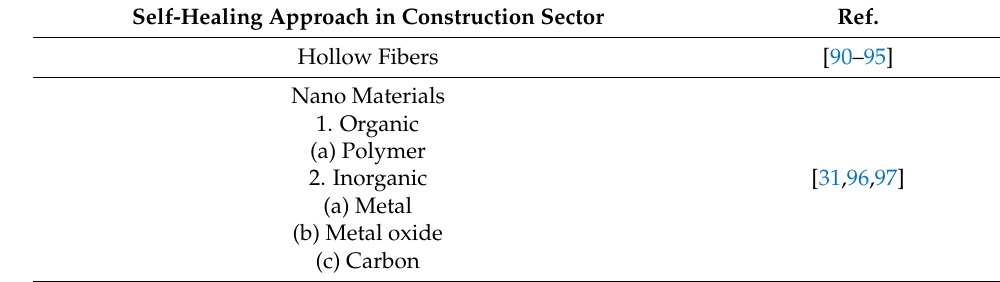
Figure 1. Approaches of self-healing for construction composites. Table 1. Self-healing approach in construction sector.